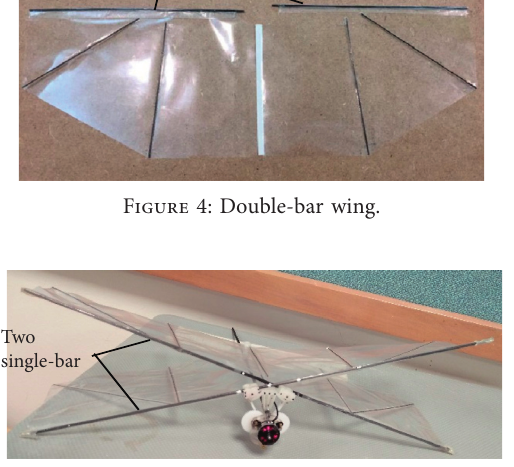
Figure 5: Single-bar